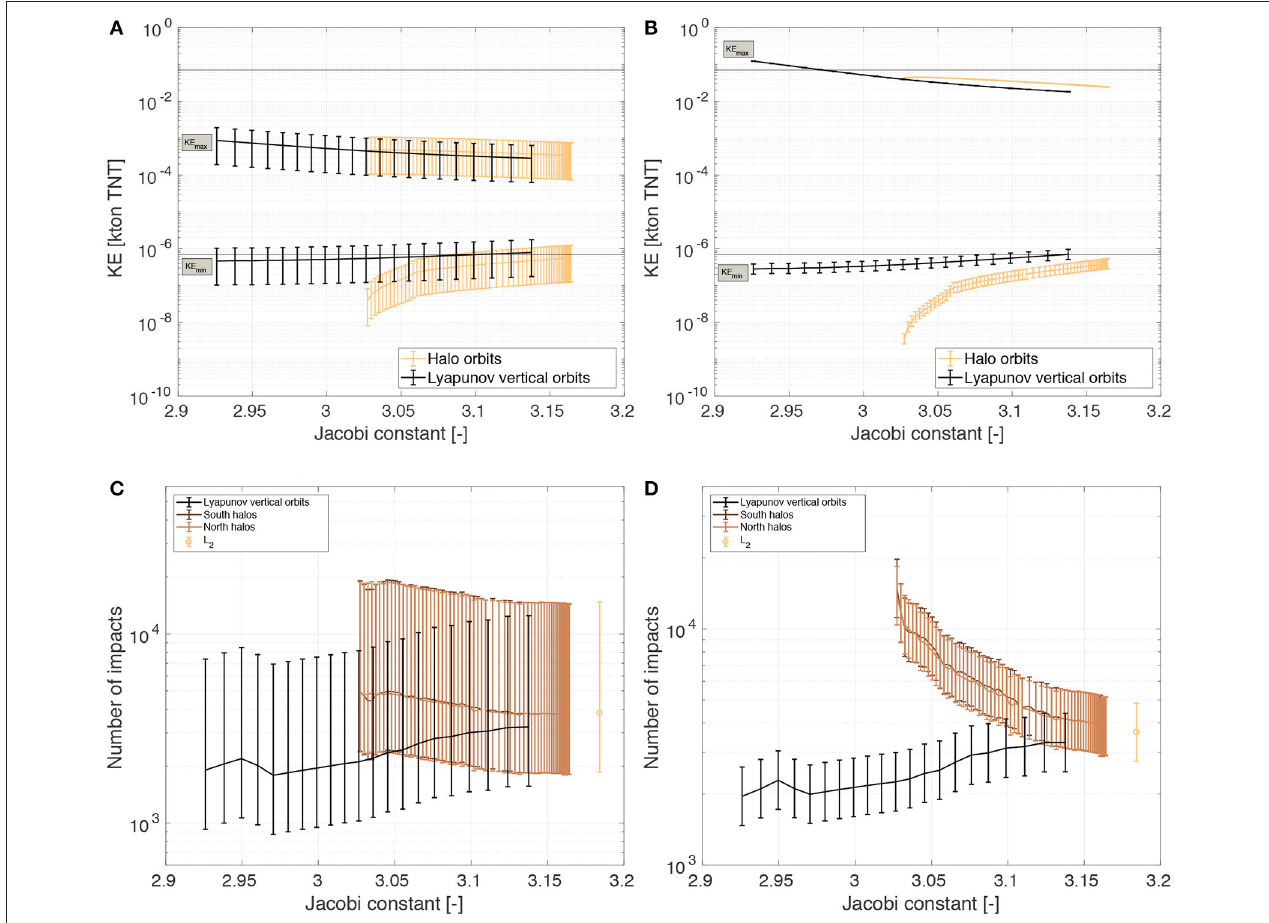
FIGURE 4 | Estimation of detectable kinetic energy range and meteoroid impacts for the considered three-body orbits over the mission lifetime. Black lines represent the kinetic energy limits as set in the requirements (corrected for the Moon). (A) Luminous efficiency method. (B) Blackbody method. (C) Detectable meteoroids (LE). (D) Detectable meteoroids